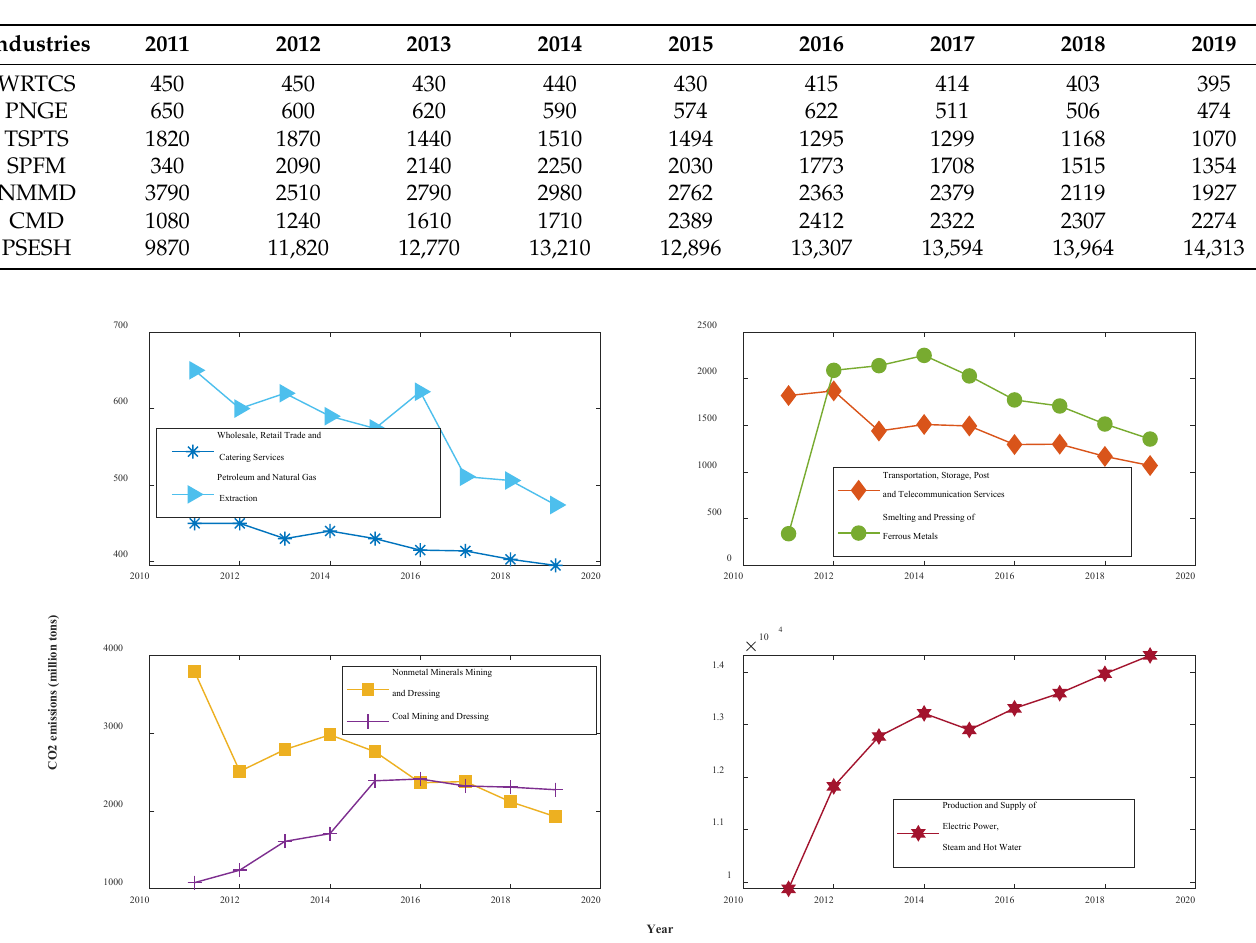
CO 2 emissions from CMD have only slightly decreased since 2016. In contrast, the amount of CO 2 emitted from PSESH has been increasing at an average annual rate of 4.9%. Table 1. CO 2 emissions from 7 industries in Shaanxi, 2011–2019 (million tons).